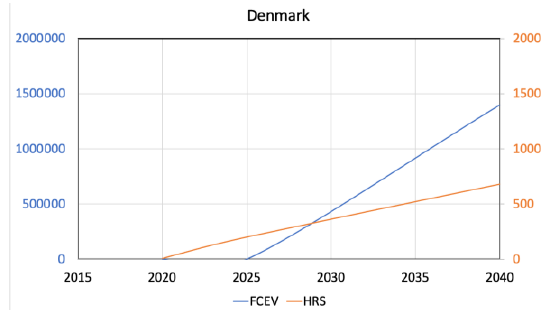
Fig. 2. The number of HRS and FCEVs in Denmark